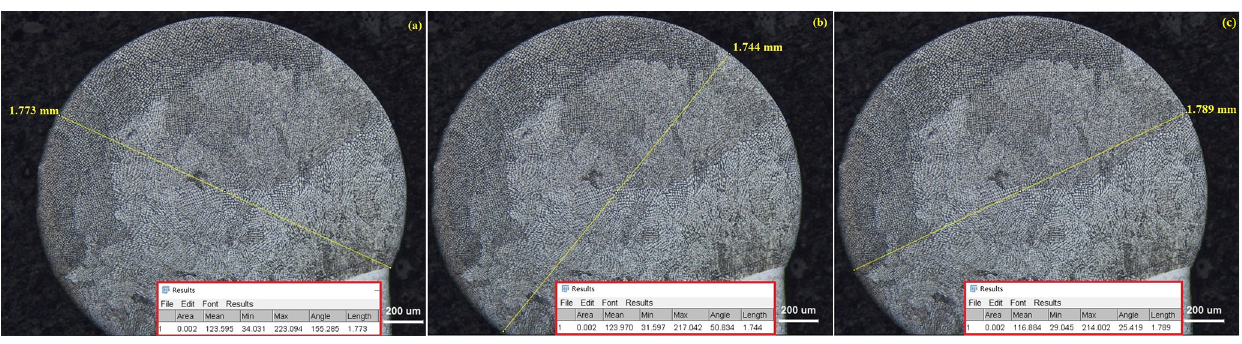
After calculation, the numerical solutions are shown in